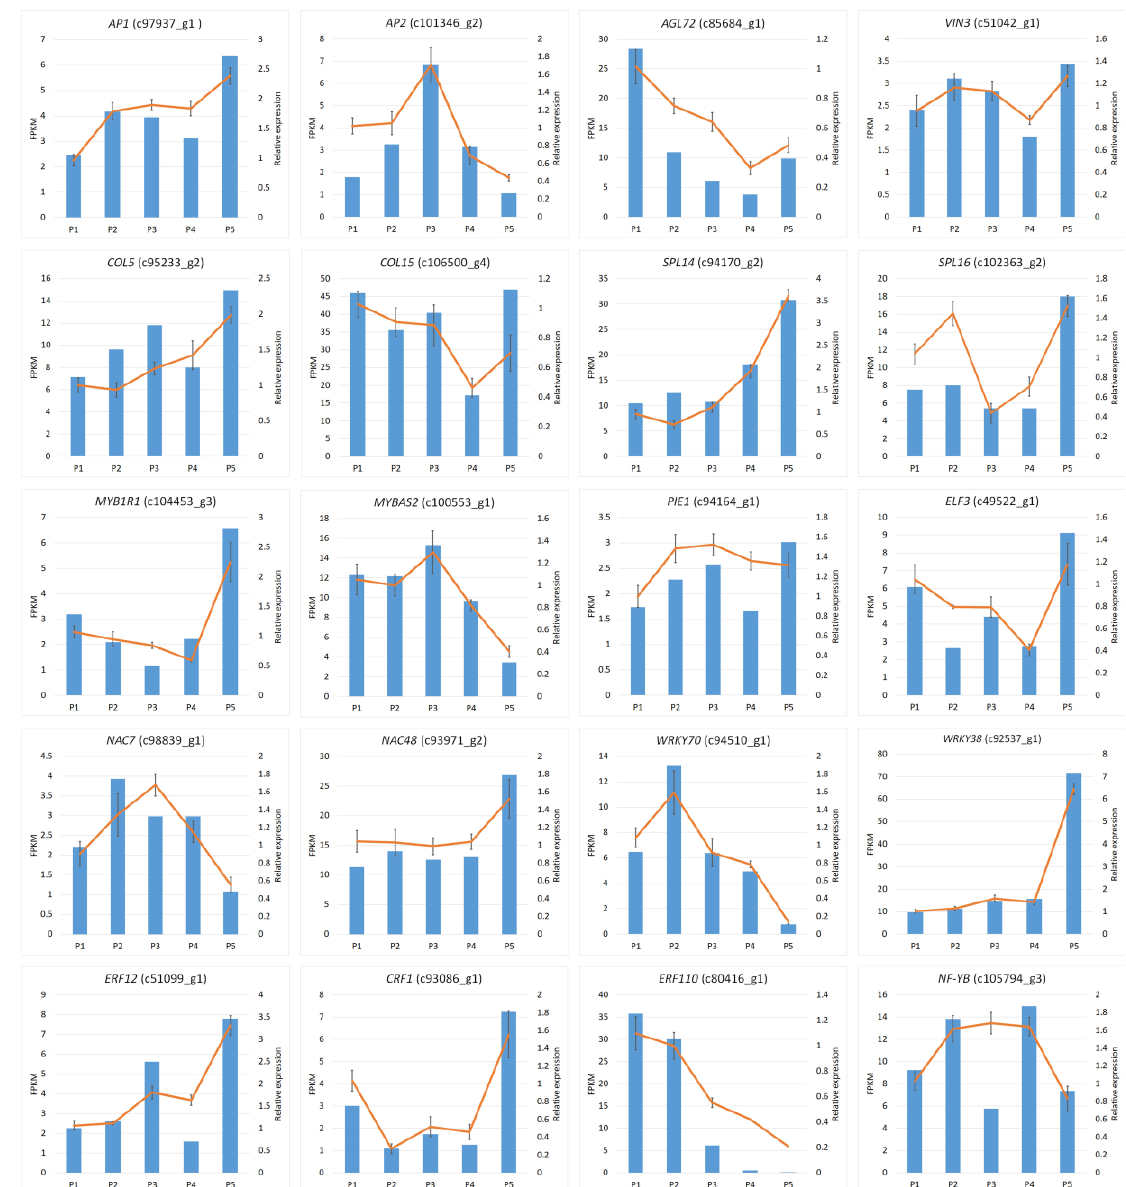
Figure 7. qRT-PCR validation of the expression level of 20 DEGs related to plant flowering. The x-axis shows the five samples, and the y-axis shows the FPKM by RNA-Seq and the relative quantitative expression level by qRT-PCR for each